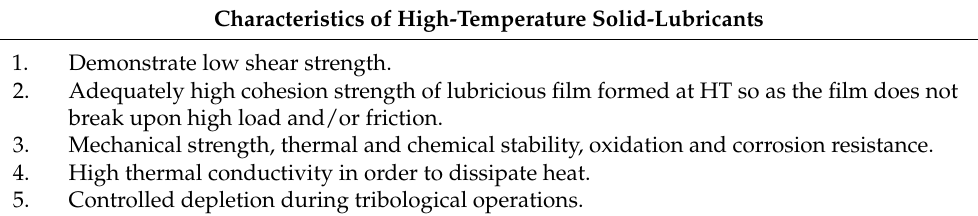
Table 1. Key characteristics of high-temperature solid lubricants (self-lubricating material).